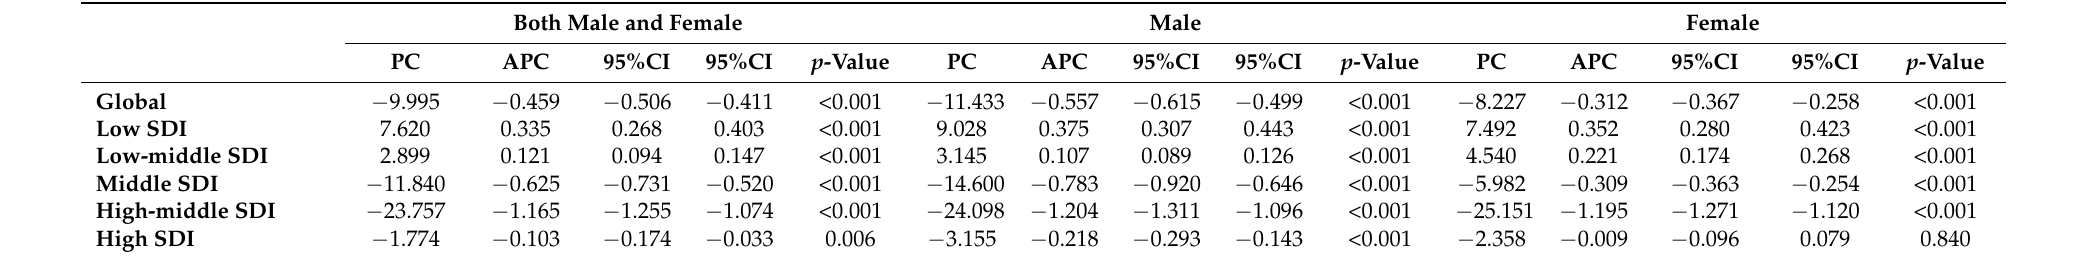
Table 4. Percentage change and annual percentage change of age standardized incidence rate of urolithiasis stratified by gender and SDI